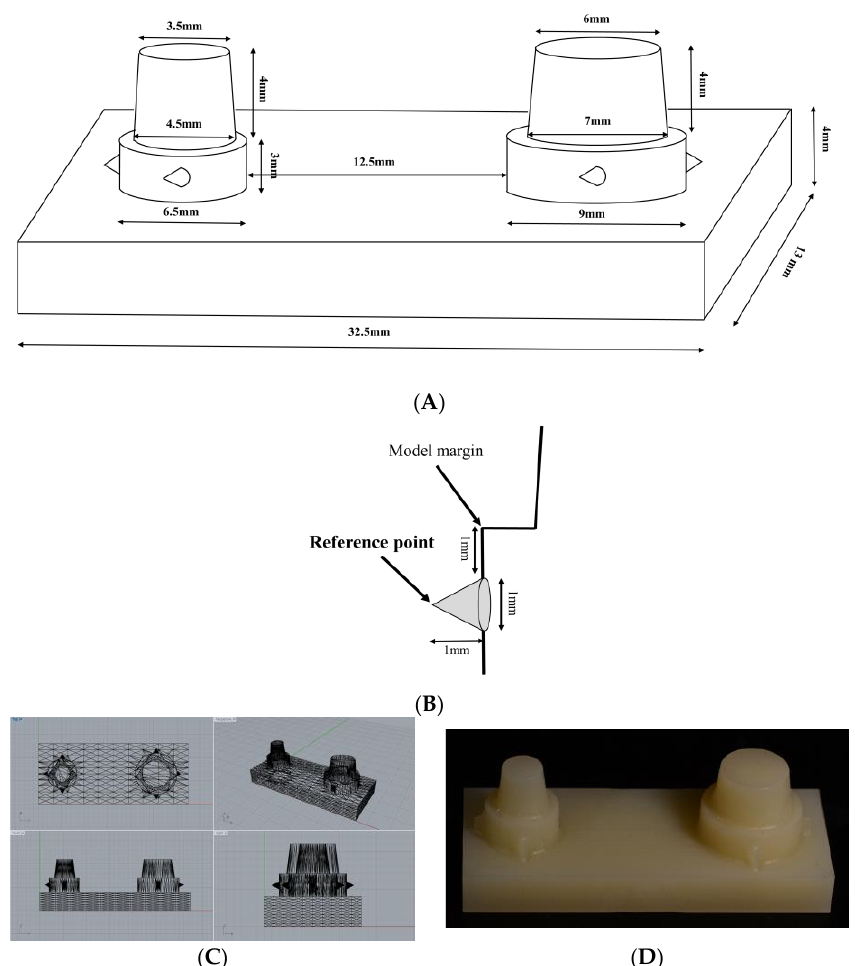
Figure 1. ( A ) The model design for two-implants supported three-unit dental prosthesis, ( B ) design of the reference point in the model, ( C ) computer-aided design (CAD) design of the model in various view and ( D ) the model fabricated with PMMA resin.